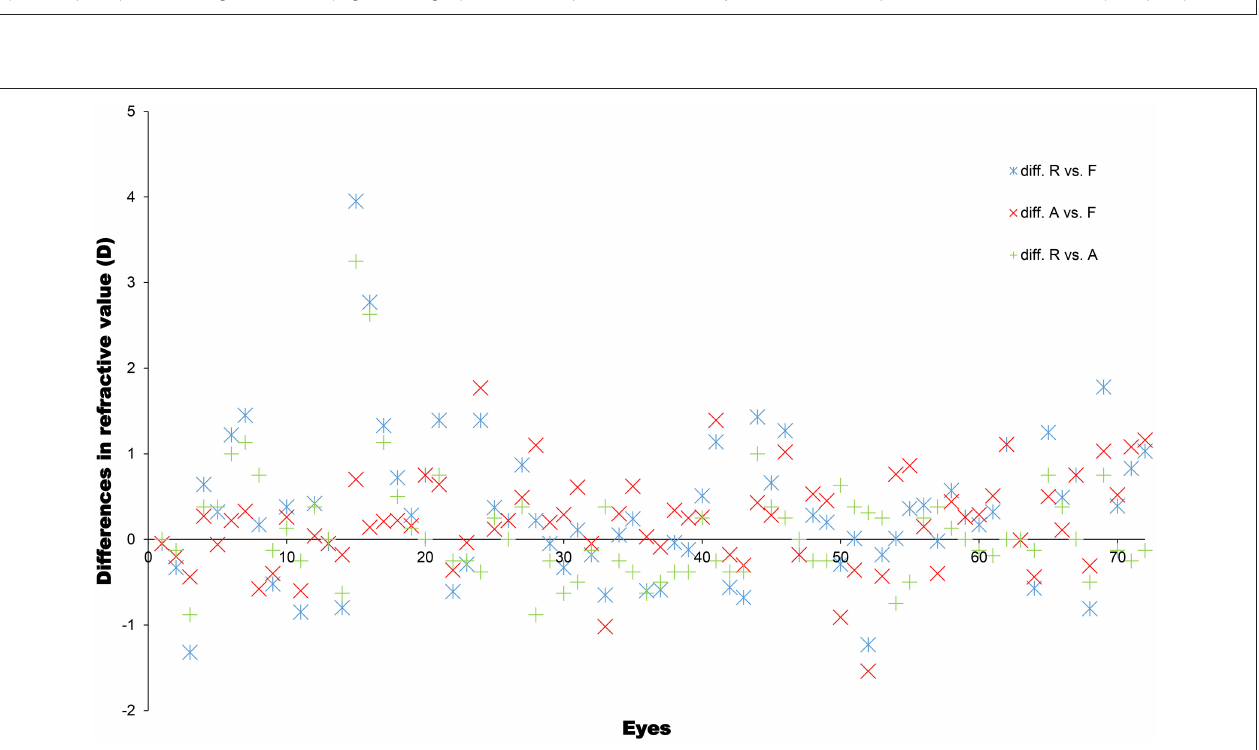
FIGURE 3 | Differences in spherical equivalent refractive values (in dioptres), determined using a refractometer (R), automatic refractometer (A), and the vergence formula (F), for each eye.